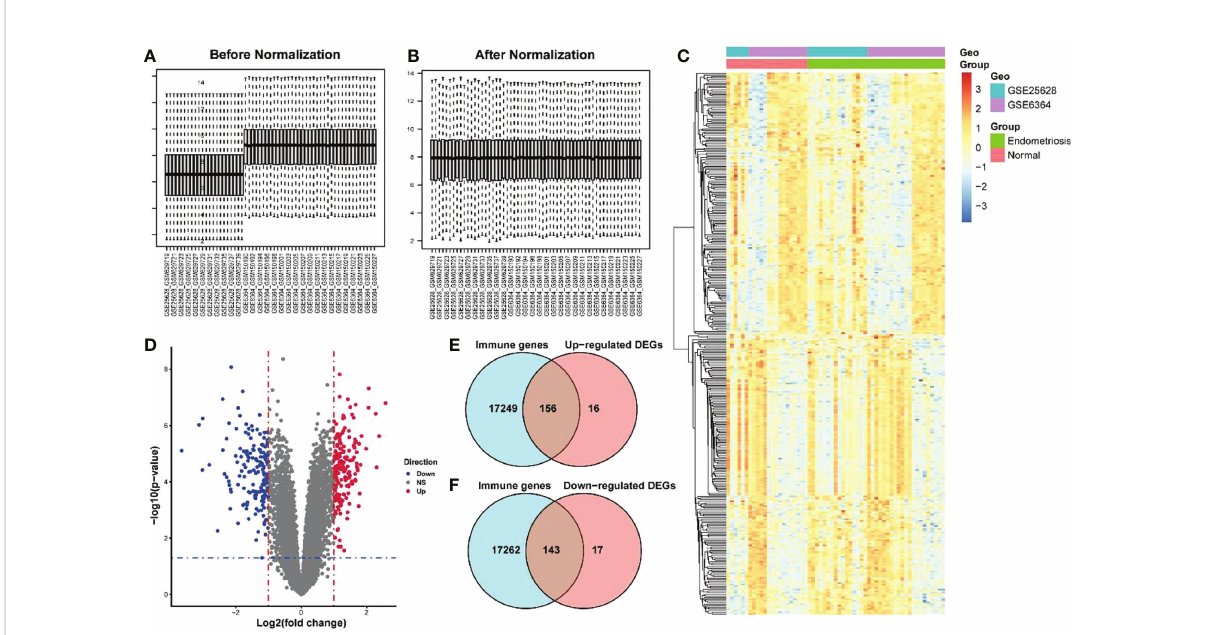
FIGURE 1 Screening of differentially expressed immune genes. (A) Bar chart before correction for batch joint analysis of GSE25628 and GSE6364 datasets; (B) Bar chart after correction for batch analysis of GSE25628 and GSE6364 datasets; (C) Heat map of differentially expressed genes; (D) Volcano map of differentially expressed genes, red represents up-regulated molecules in the disease group, blue represents down-regulated molecules in the disease group, and gray represents no differentially expressed molecules. Level of the blue line represents the p - value < 0.05 threshold, the vertical red line represents thea fold change> 1 threshold; (E, F) Venn diagram for screening differentially expressed immune genes.